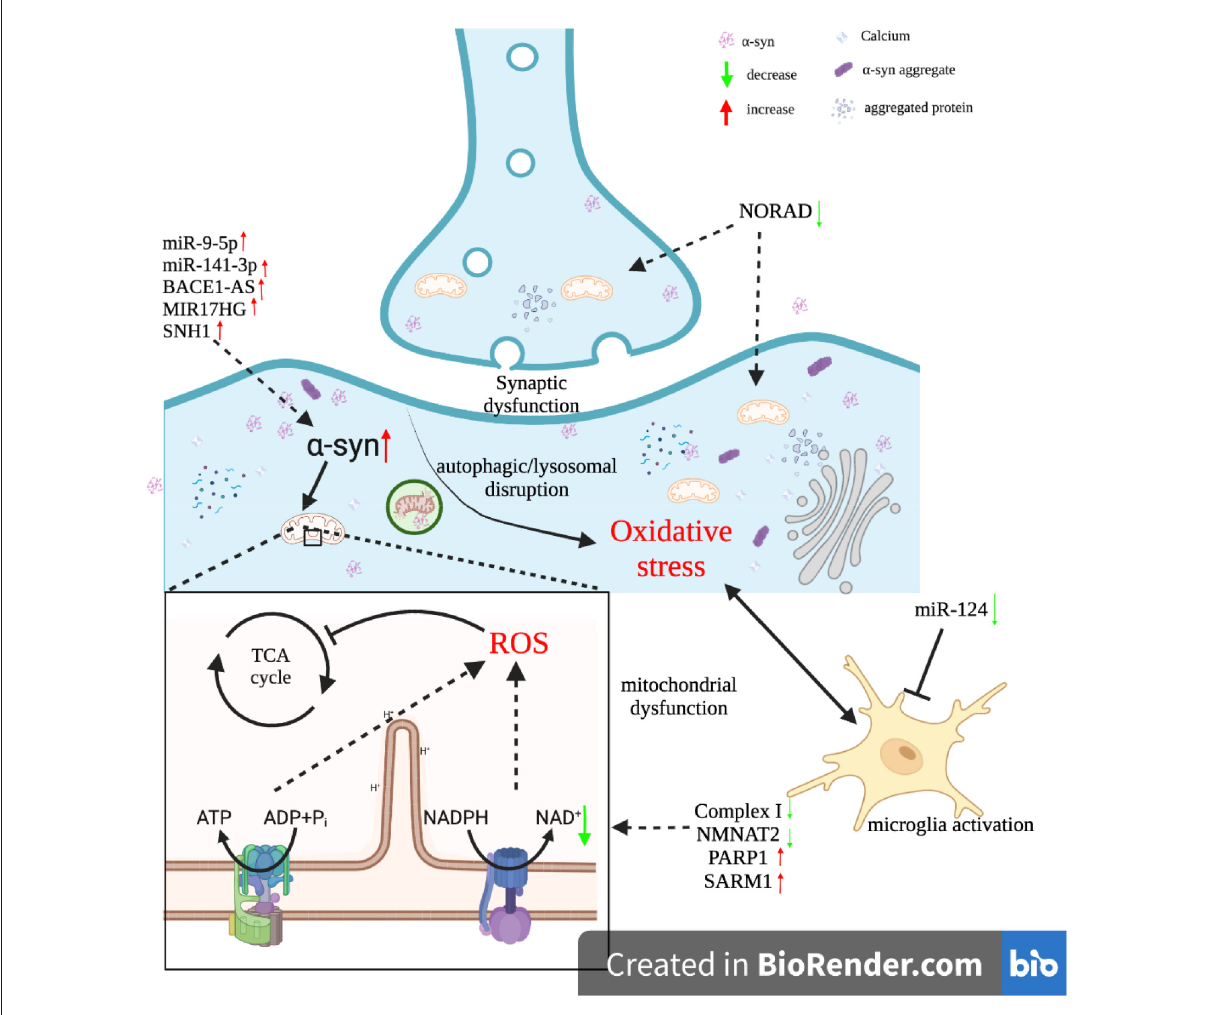
FIGURE2 Interactions between ncRNAs and oxidative stress in Parkinson’s